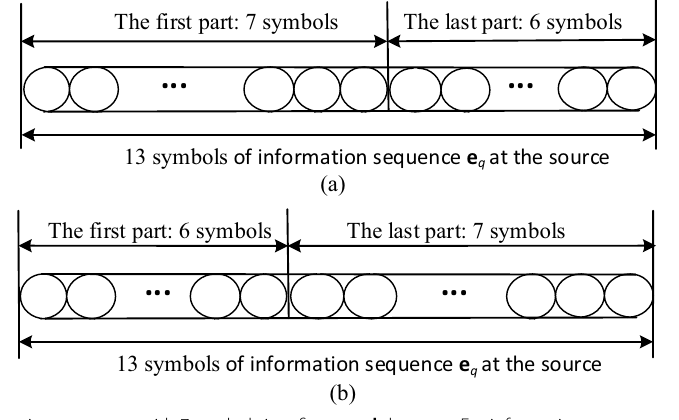
Fig. 4 Information sequence with 7 symbols in a first part, b last part. For information sequence with length K 1 = 13 at the source node, its symbols are divided into two cases. One case is the first part has more symbols (7 symbols), and the other case is that the last part has more symbols (7 symbols). a denotes the symbol diagram of information sequence with more symbols (7 symbols) in the first part. b denotes the symbol diagram of information sequence with more symbols (7 symbols) in the last part